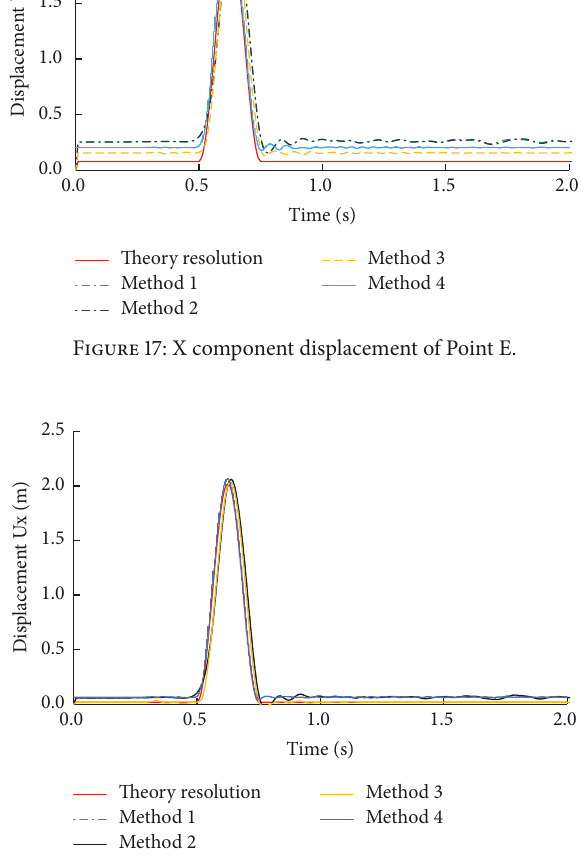
Figure 18: X component displacement of Point